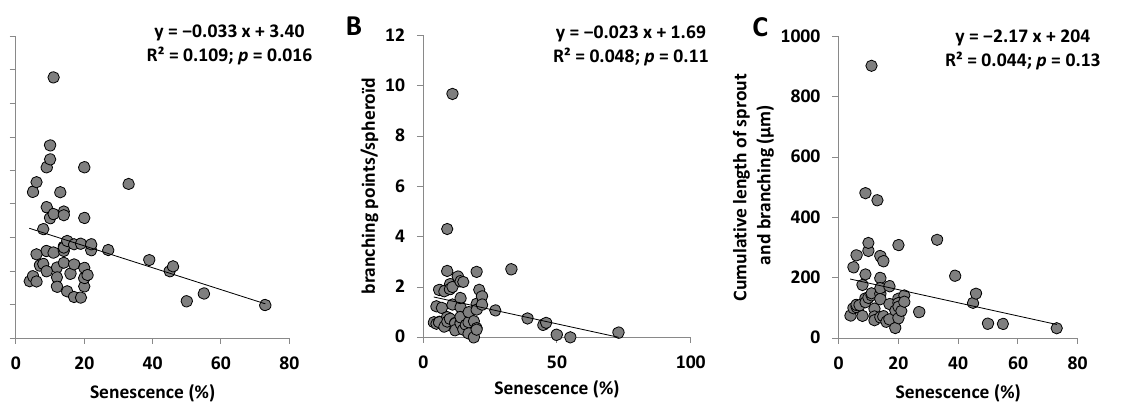
Figure 3. ECFC vasculogenic potential according to the presence and severity of ASCVD. ECFC were used at passage 3 as described in Materials and Methods. ( A ) Representative experiment of capillary-like sprout formation from 3D in vitro angiogenesis assay with collagen gel-embedded spheroids obtained with ECFC from patients according to the extent of ASCVD (number of ASCVD) (magnification 20 × ). ( B – D ) Quantification of the number of branching points ( B ), the number of sprouts ( C ), and the cumulative length ( D ) per spheroids according to the absence or presence of ASCVD. For each experiment, sprouts from 20 spheroids were counted. Data represent means ± SD of 55 independent experiments. ASCVD indicates atherosclerotic cardiovascular disease. p of comparisons are obtained from the Mann–Whitney test.